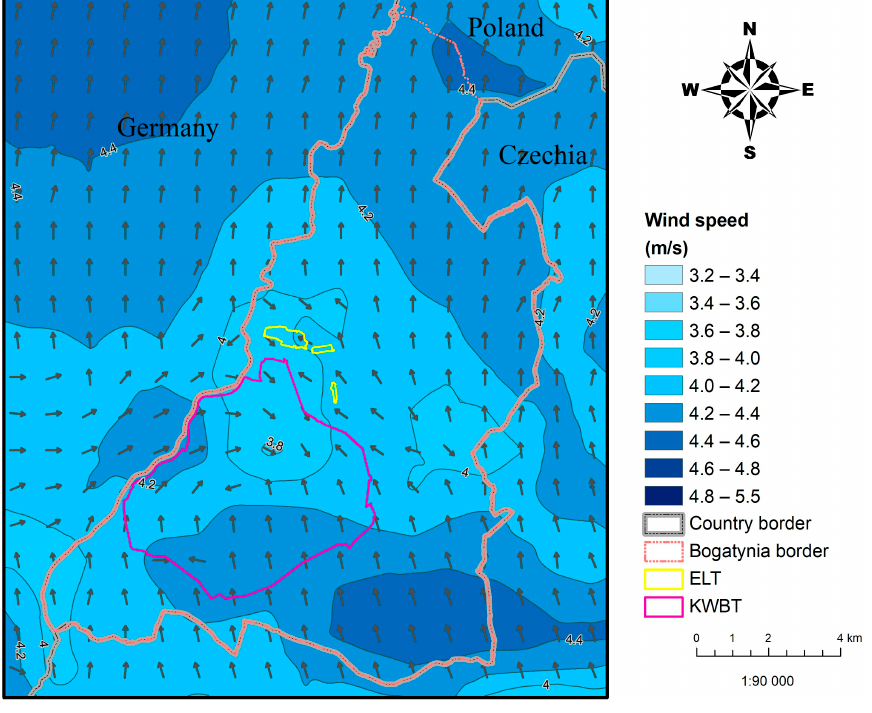
Figure 7. Spatial distribution of annual mean speeds and dominant wind direction determined by the WRF / CALMET model in 2018 (source: own study).